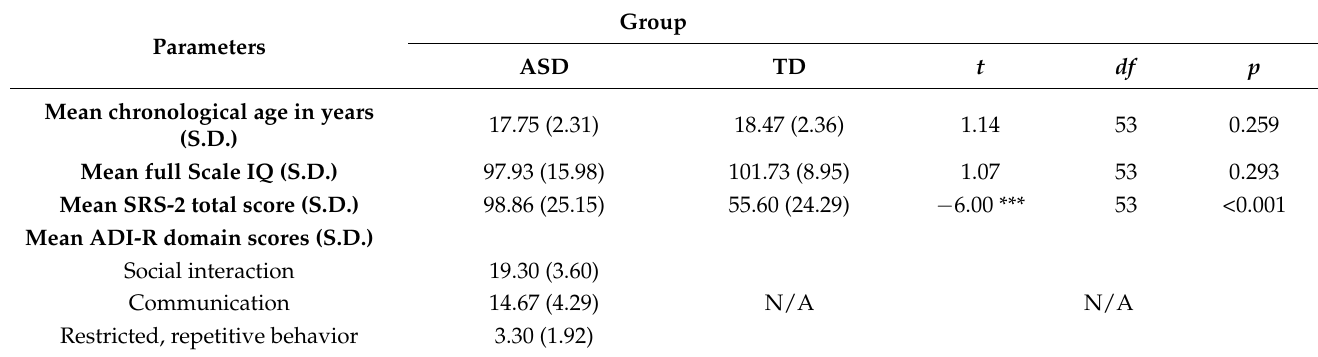
Table 1. Participants’ demographic